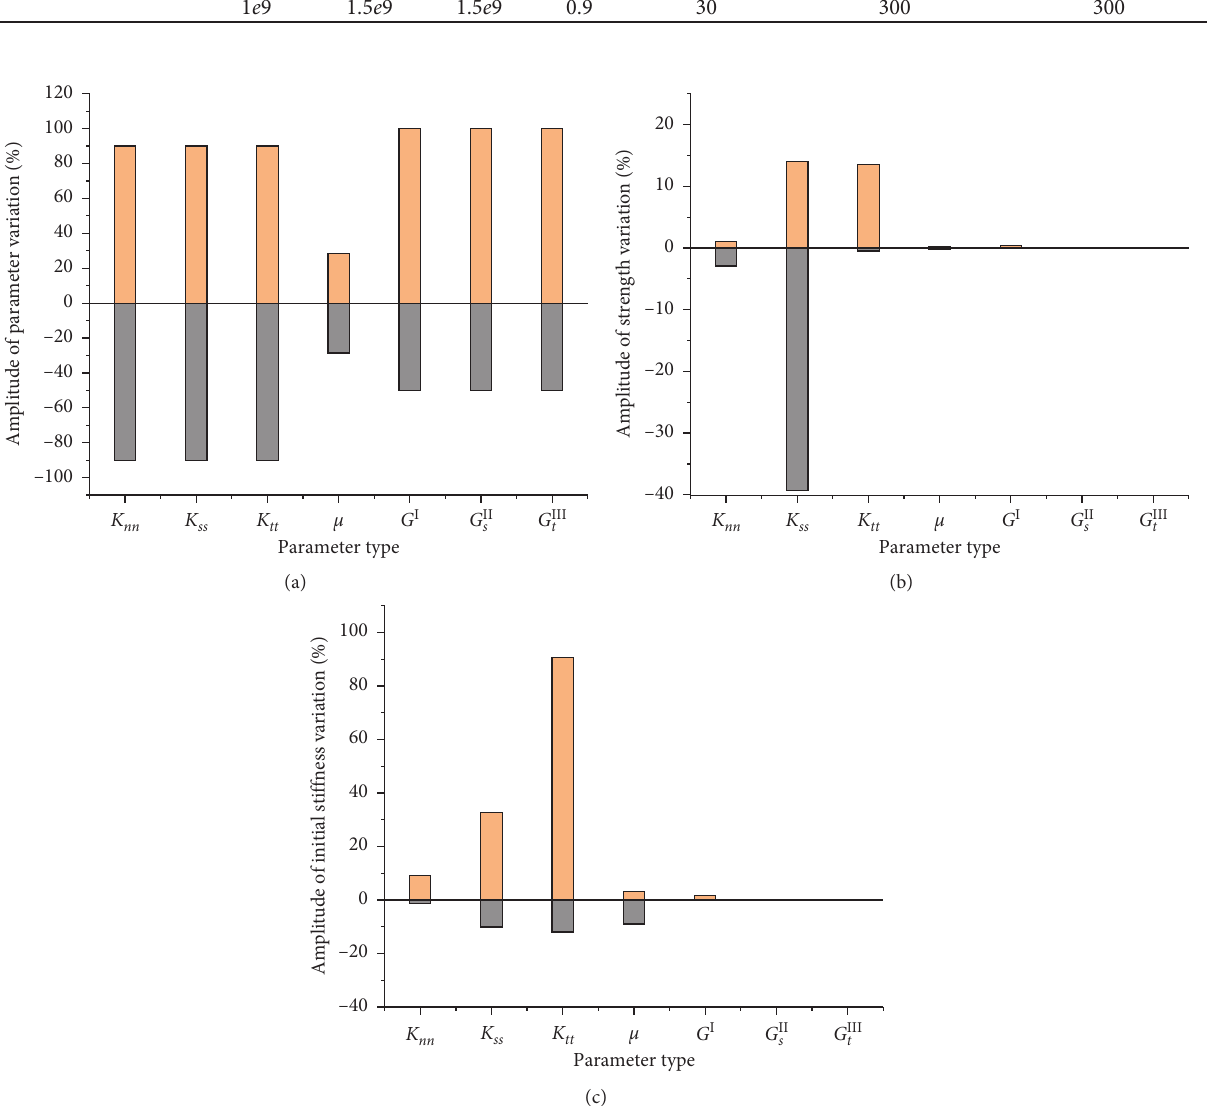
Figure 5: Percentage change of modeling parameters and structural response. (a) Parameter variation. (b) Ultimate load. (c) Initial